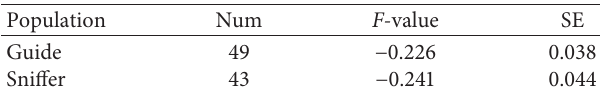
Table 6: F -value of an inbreeding coefficient in sniffer dogs and guide